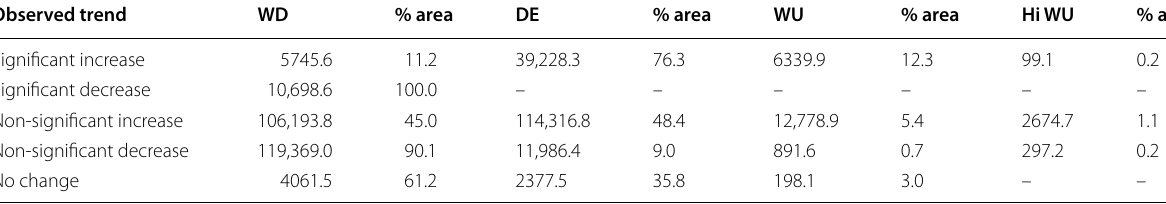
WD is for Woinda dega, DE for Dega, WU for Wurch, Hi WU for High Wurch